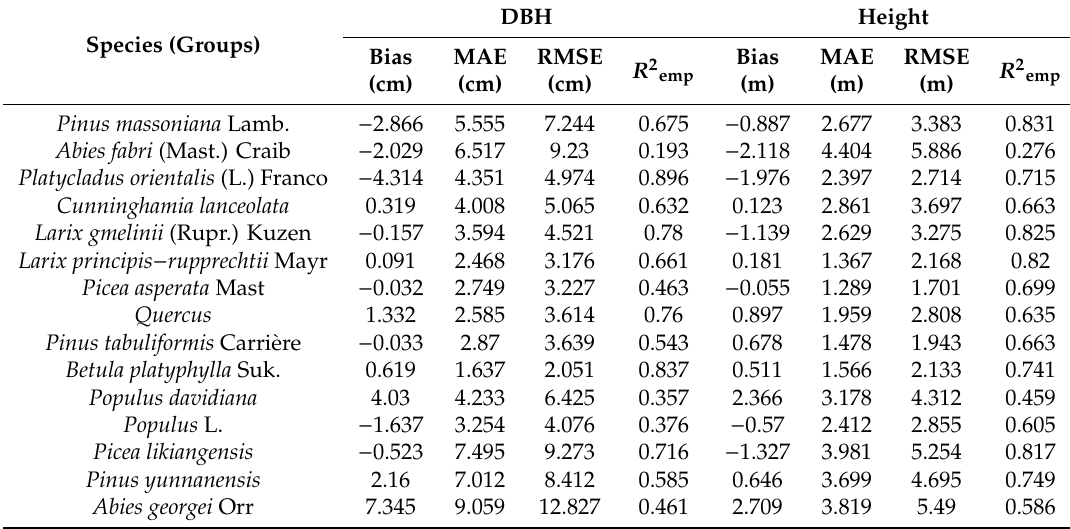
Table A7. Validation precision of the Logistic (1983) model for di ff erent tree species.